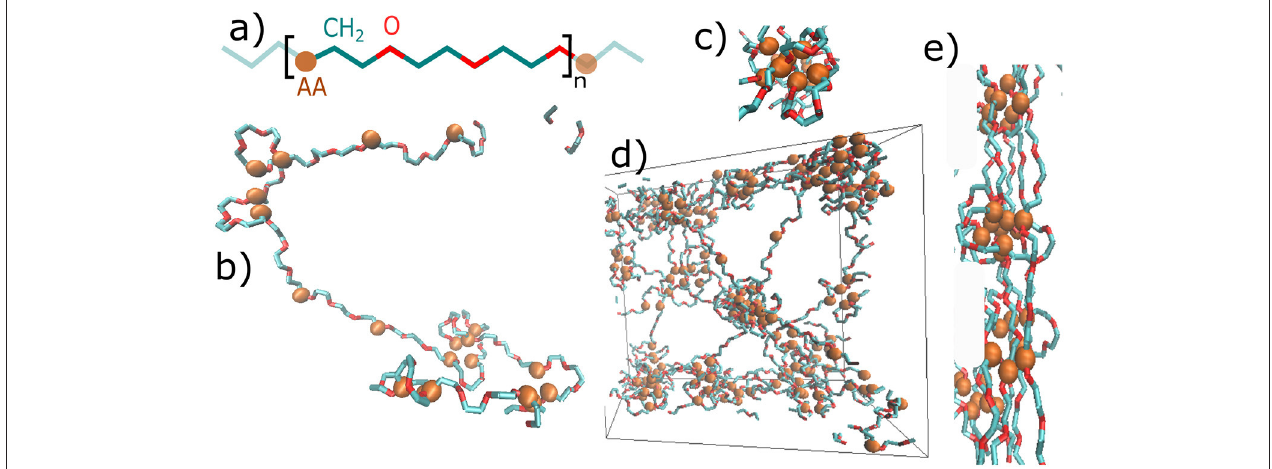
FIGURE 2 | Snapshots of the hydrogel molecular structure: (a) primary structure—repeating unit of the chain: blue—methylene group of polyethylene glycol, red—oxygen of polyethylene glycol, AA —physically interacting group; (b) Secondary structure of a single chain: loops and stretched chains; (c) a single micelle; (d) dry phase of network: entire box (box side = 5 nm ); (e) fibril formed by deformation.